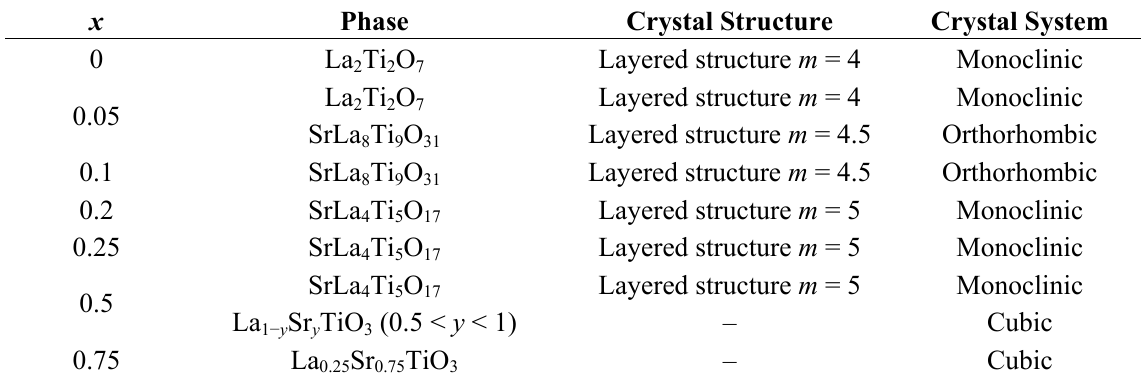
Sr TiO as functions of x (0 ≤ x <1). 1− x x 3+δ